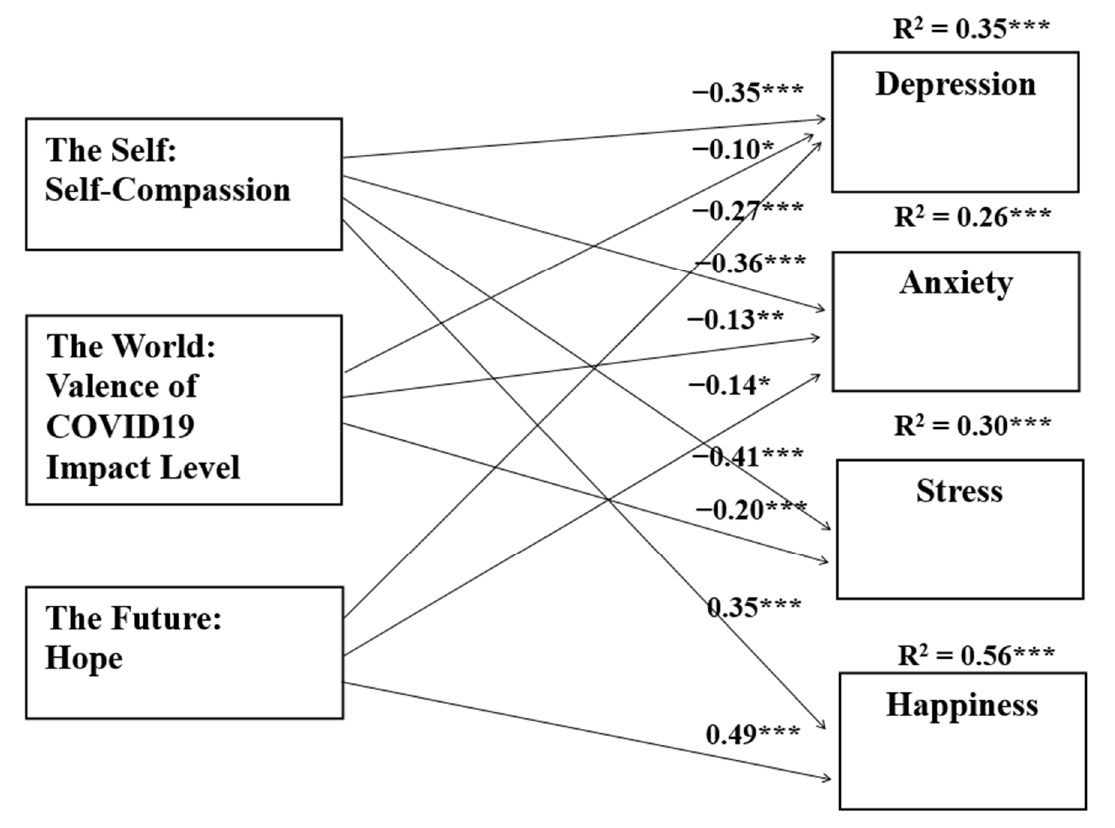
Figure 1. Standardized coefficients ( β ) for prediction of depression, anxiety, stress, and happiness by self-compassion, impact of COVID-19, and hope ( N = 345). Note. * p < 0.05, ** p < 0.01, *** p < 0.001.